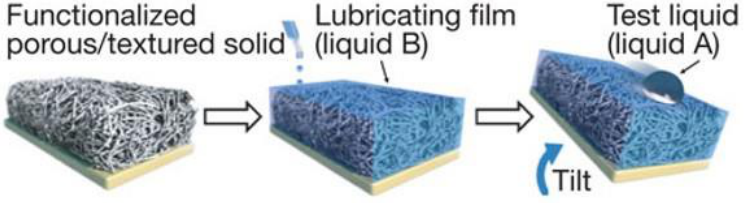
Figure 9. Schematic diagram of preparation process of a slippery surface (Reprinted with permission from Ref. [50]. 2011, Wong, T.S.).